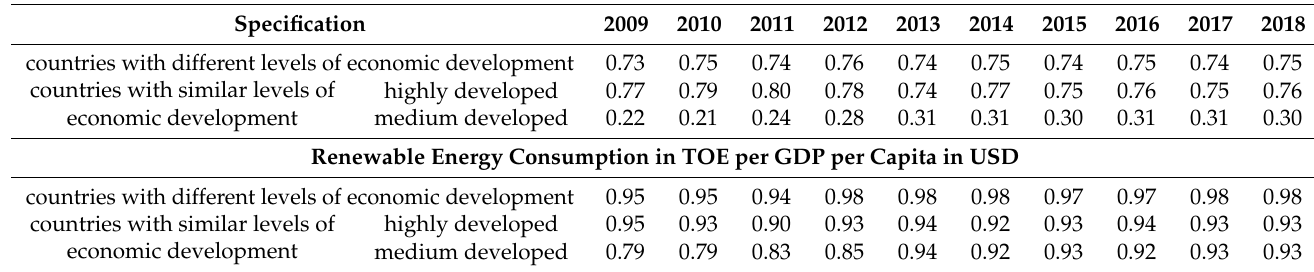
Table 10. Sigma coefficients ( σ )-convergence in the studied EU countries with different and similar levels of economic development with regard to renewable energy consumption—in TOE per 1000 inhabitants and in TOE per GDP per capita in USD.